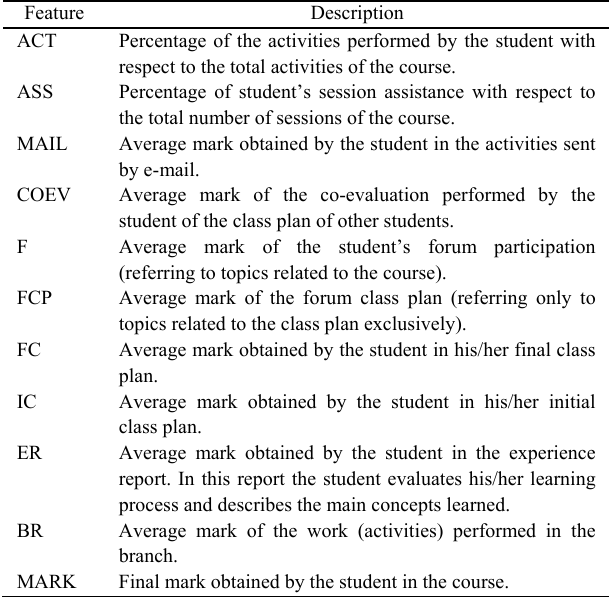
Table 5. Data features collected for the didactic planning course.